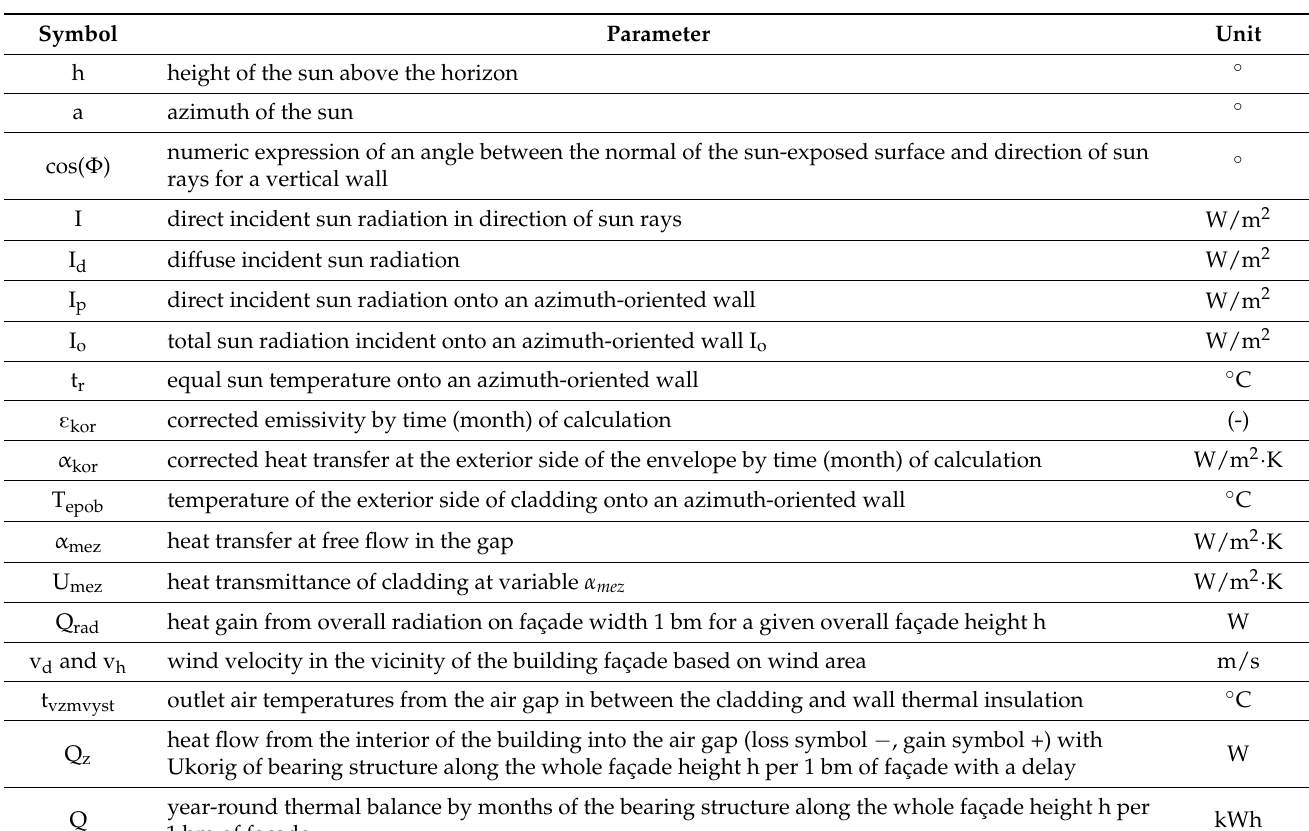
Table 4. Calculation itself is then based on